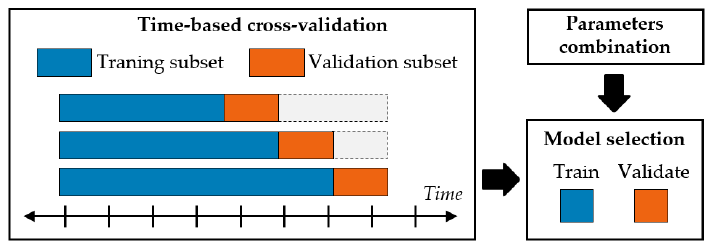
Figure 5. The time-series cross-validation technique on a rolling basis. The fold is three.